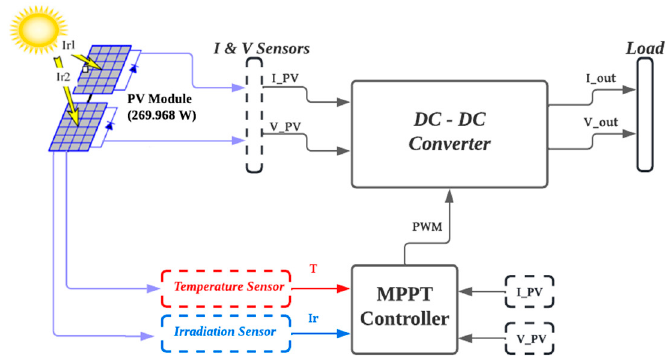
Figure 10. General block diagram of the PV system.